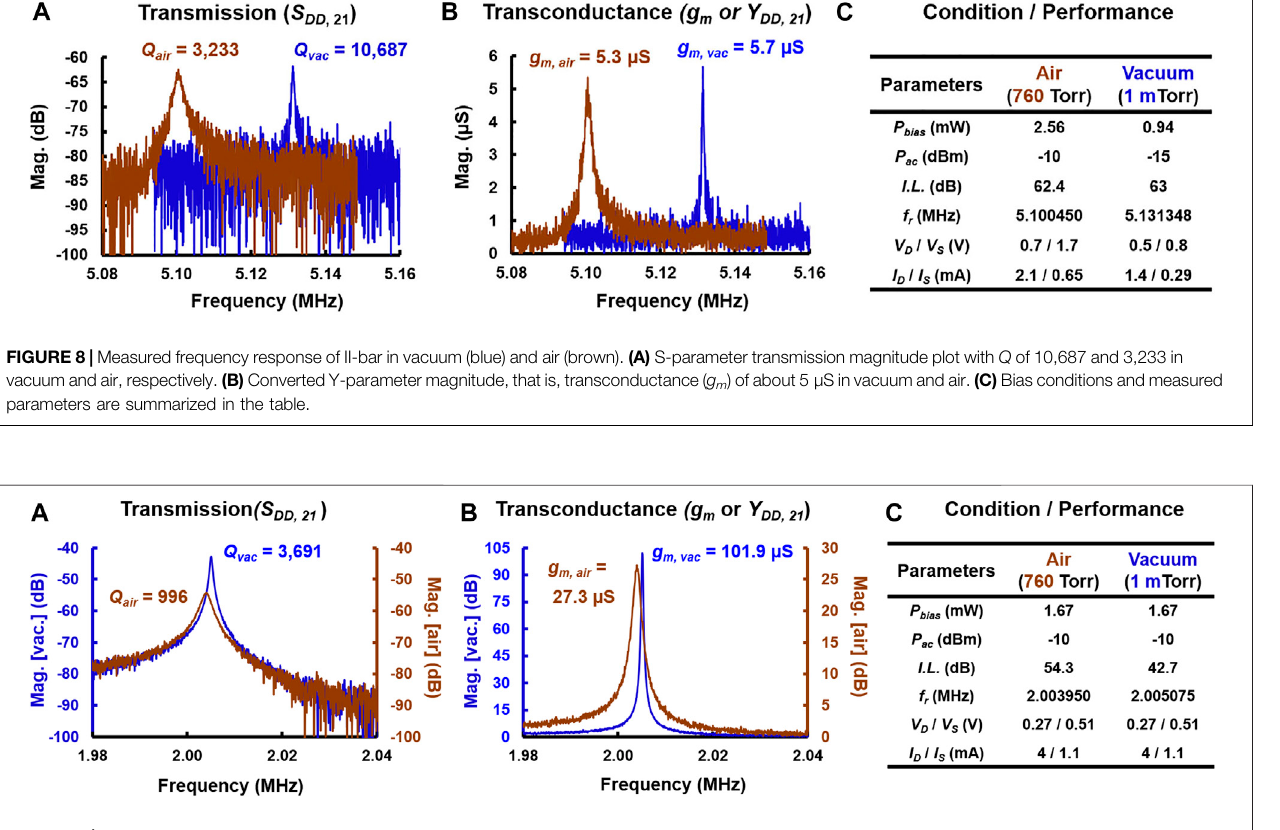
FIGURE 9 | Measured frequency response of CCB in vacuum (blue) and air (brown). (A) S-parameter transmission magnitude plot with Q of 3,691 and 996 in vacuumandair,respectively. (B) ConvertedY-parametermagnitude,thatis,transconductance(